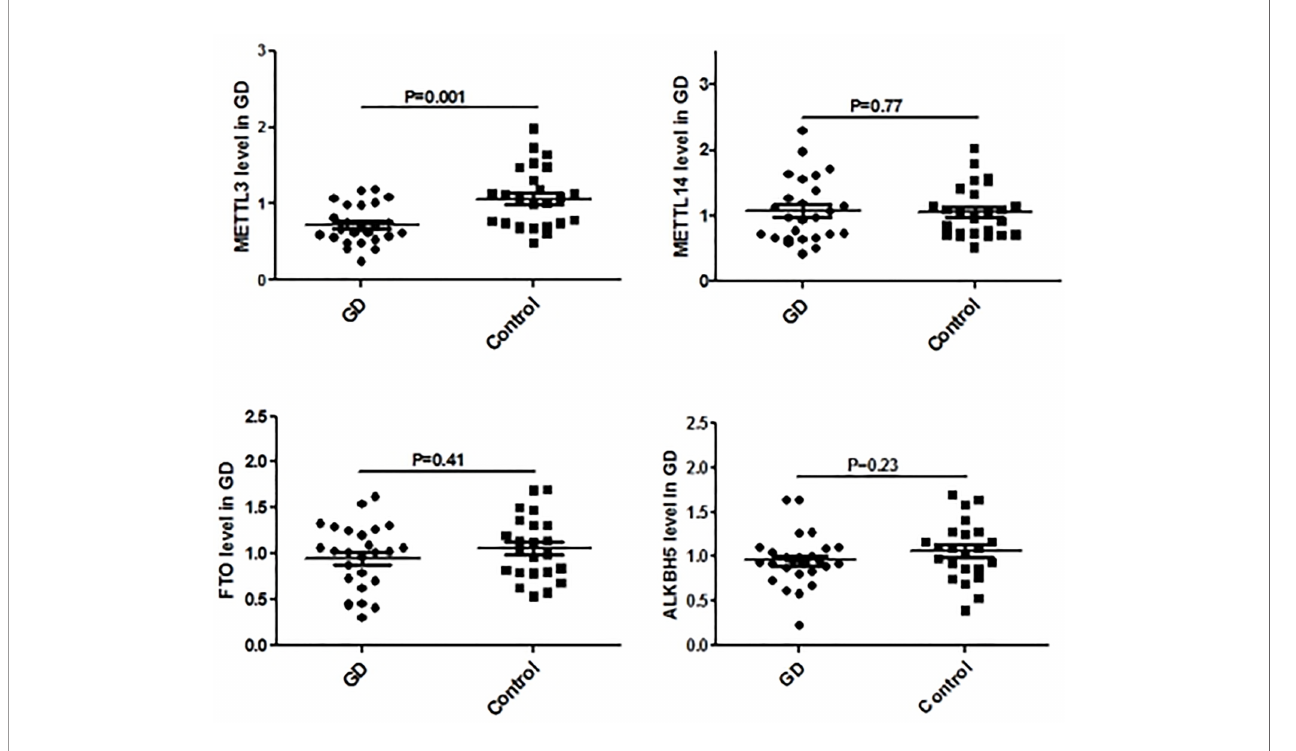
FIGURE 5 | mRNA modi fi cation key enzymes ’ expressions in PBMCs of GD.